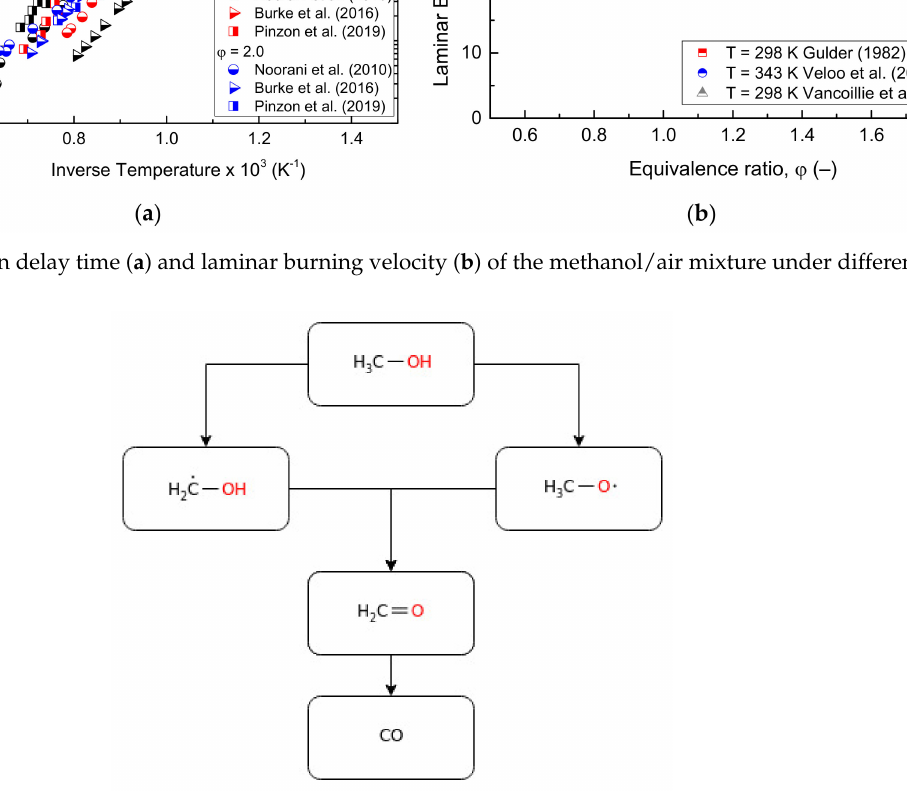
Figure 4. A simplified reaction pathway for methanol